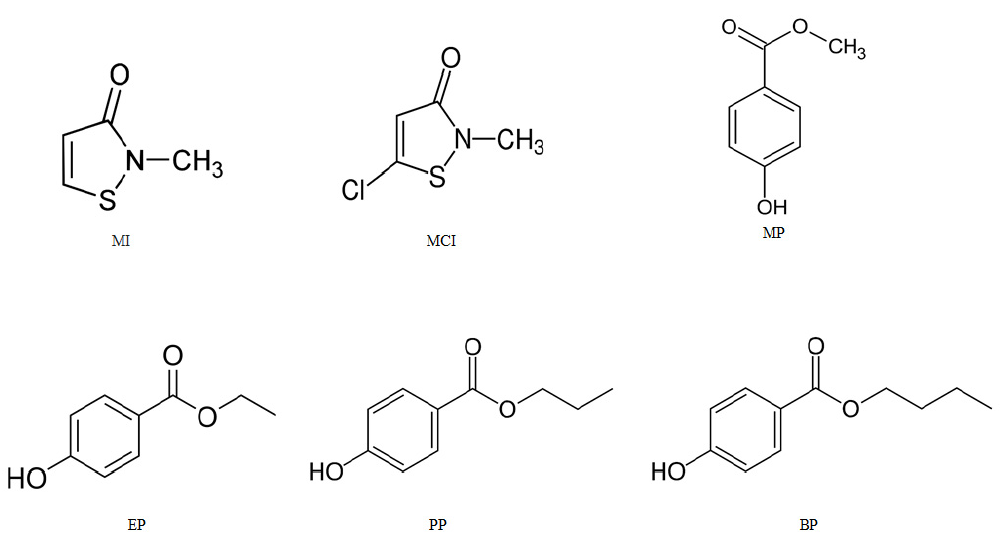
Figure 4. Structures and abbreviation of the studied compounds in cosmetic products.